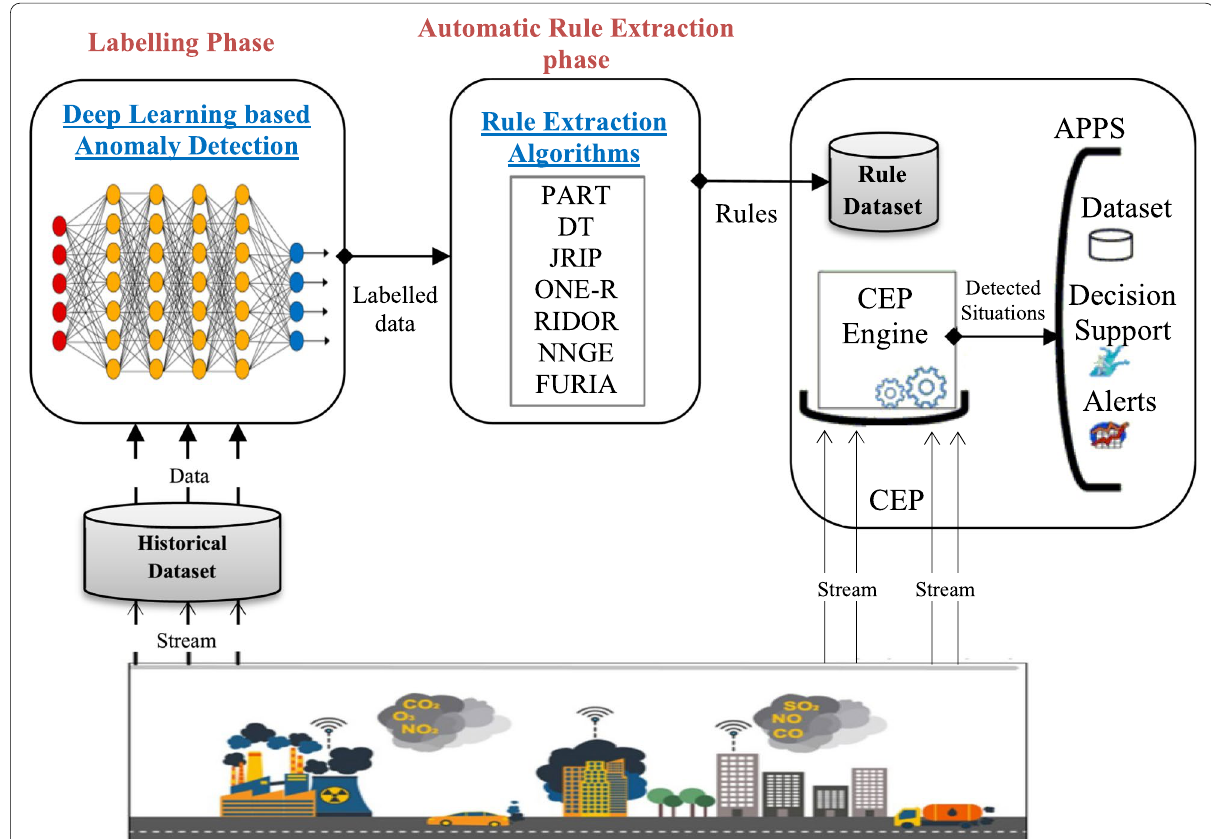
Fig. 10 Integration of CEP with DL and rule-based machine learning used in